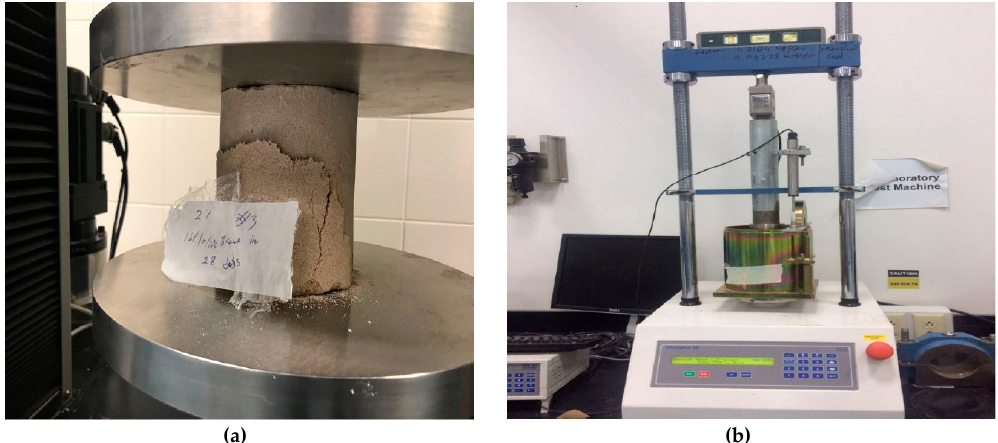
Figure 8. Unconfined compression test ( a ) and California bearing ratio (CBR) test ( b ).